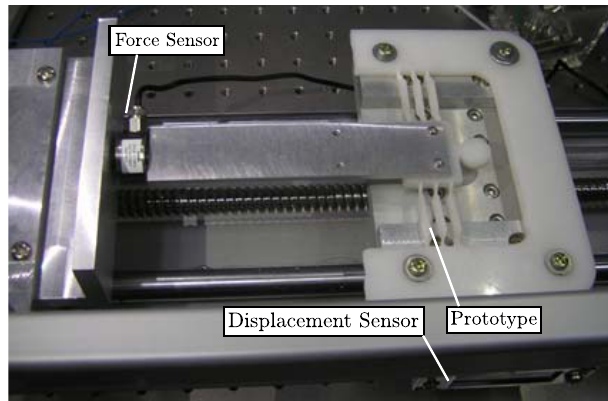
Figure 6. Experimental